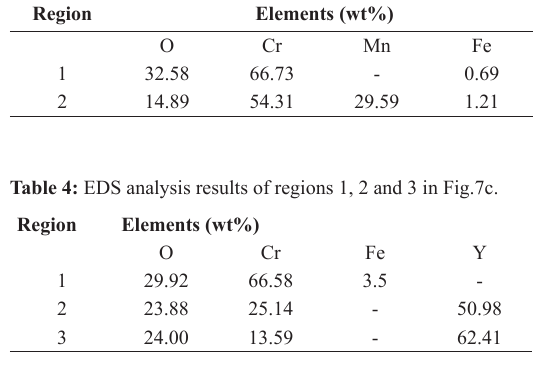
Figure 5: Mass gain per unit area after each cycle of 7 h at 1000 °C followed by cooling to room temperature of uncoated and Y coated Fe-20Cr specimens.